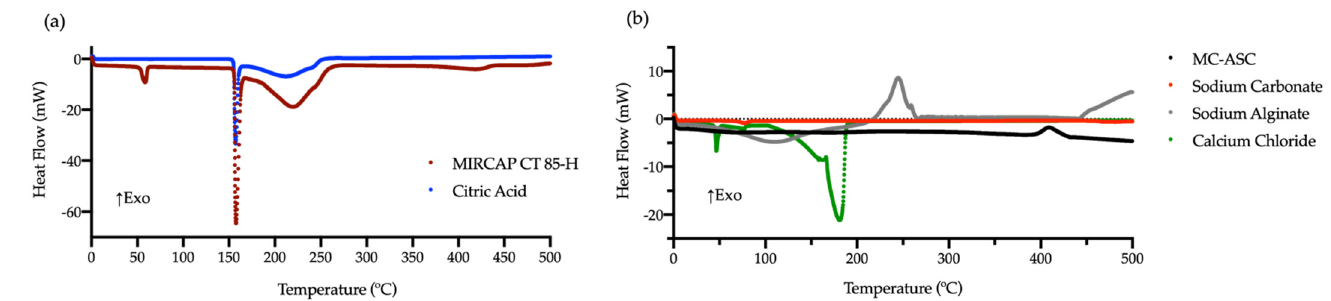
Figure 6. DSC curve of citric acid and hydrogenated palm oil encapsulated citric acid (MIRCAP CP 85 ‐ H) ( a ), and of all compounds used in the synthesis of acid neutralizer MC ‐ ASC ( b ).